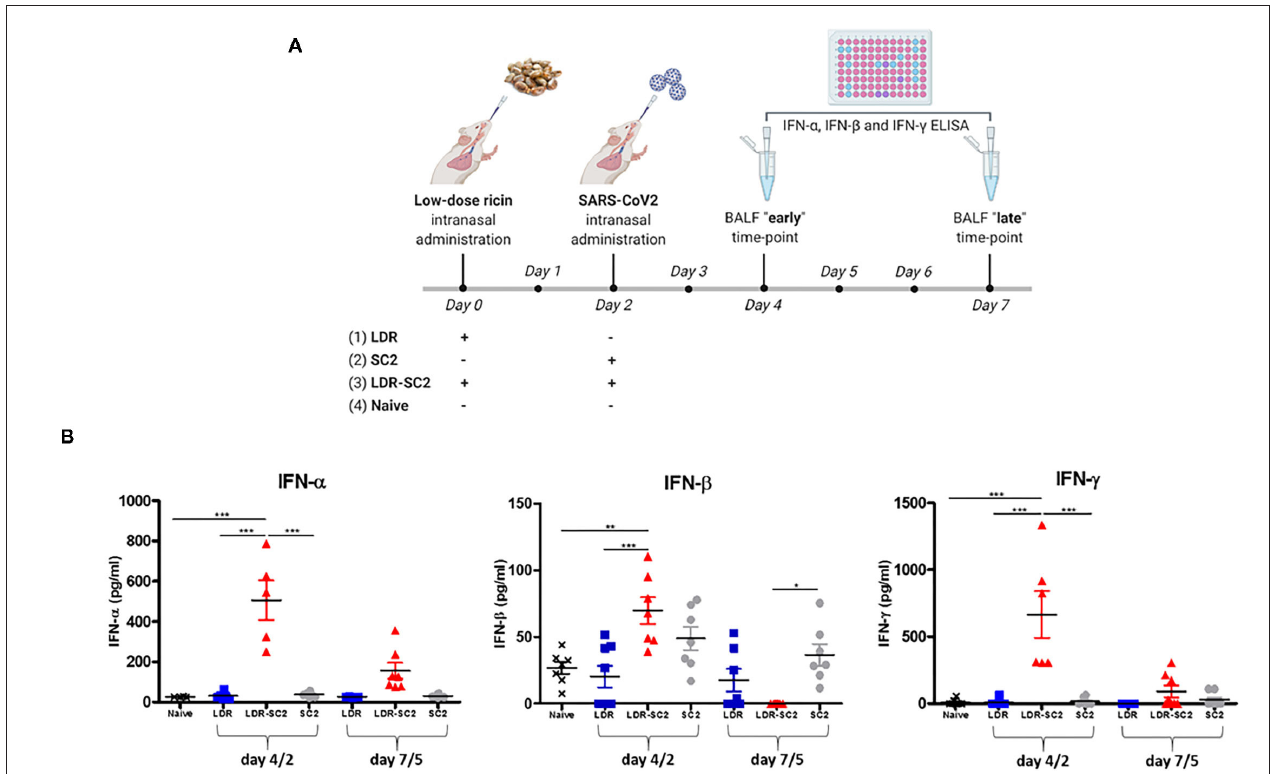
FIGURE 9 | (A) Time-table for treatment and BAL fluid collection for interferon protein quantification in the differently treated mice groups. The scheme was created with BioRender.com. (B) Interferon proteins expression in BAL fluid of mice. Concentration of Interferon- α (IFN- α ) or Interferon- β (IFN- β ) or Interferon- γ (IFN- γ ) in BAL fluid of mice treated intranasally with low dose ricin (R, day 4 or 7 post exposure) or SC2 (S, day 2 or 5 post exposure) or low dose ricin and SC2 (RS, day 4/2 and day 7/5) compared to naïve mice (N). Data presented as mean ± SEM, analyzed using 1-way ANO-VA followed by Bonferroni’s posttests. * p < 0.05, ** p < 0.01, *** p < 0.001, n = 4–8 per